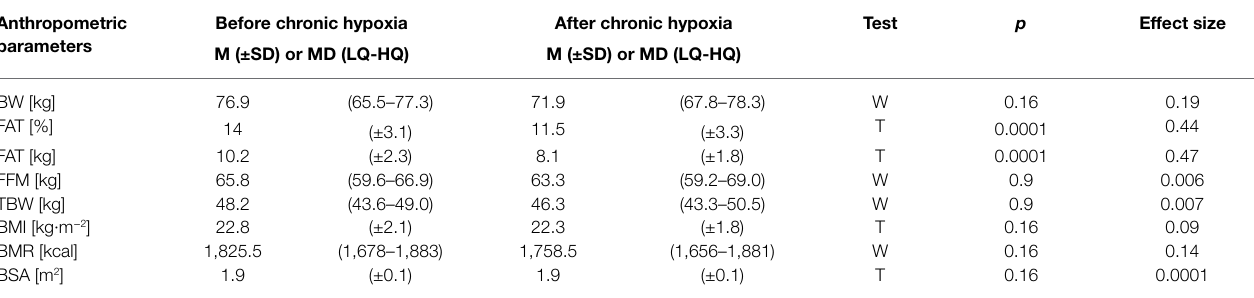
TABLE 3 | Anthropometric parameters measured before and after 1 month at very high altitude (mean altitude of 4,900 ± 60 m). Anthropometric parameters